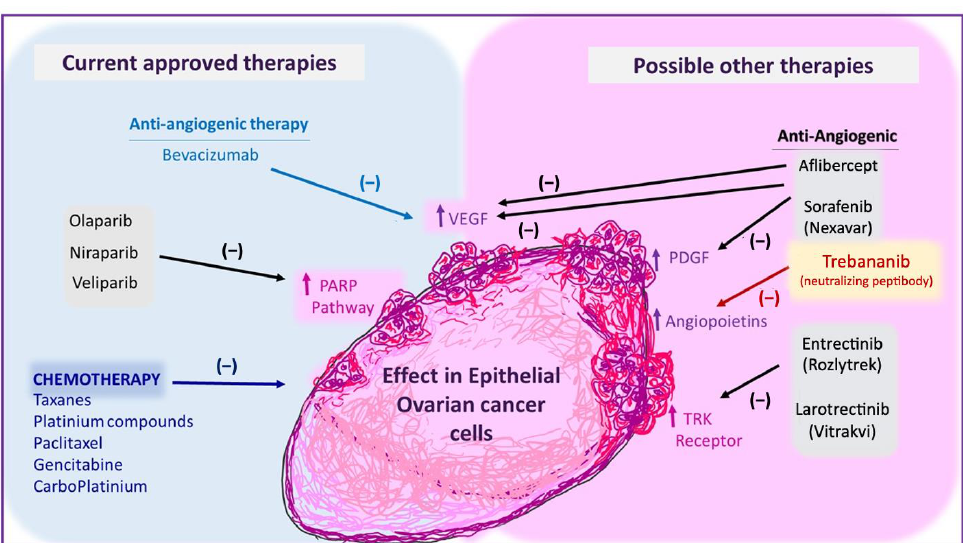
Figure 2. Summary of current and new possible therapies for ovarian cancer treatment. VEGF: vascular endothelial growth factor. PARP: poly adenosine diphosphate-ribose polymerases. TRK: tropomyosin receptor kinases. PDGF: platelet-derived growth factor.